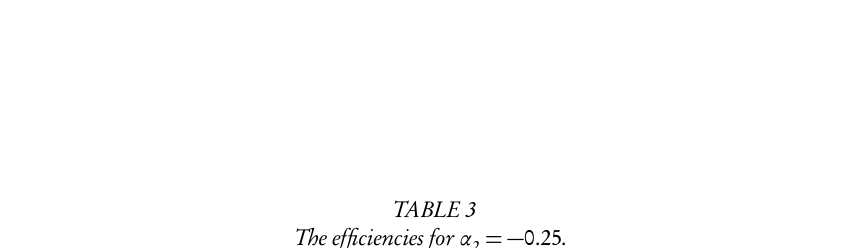
The efficiencies for α